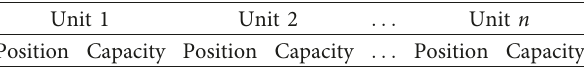
Table 1: Decision